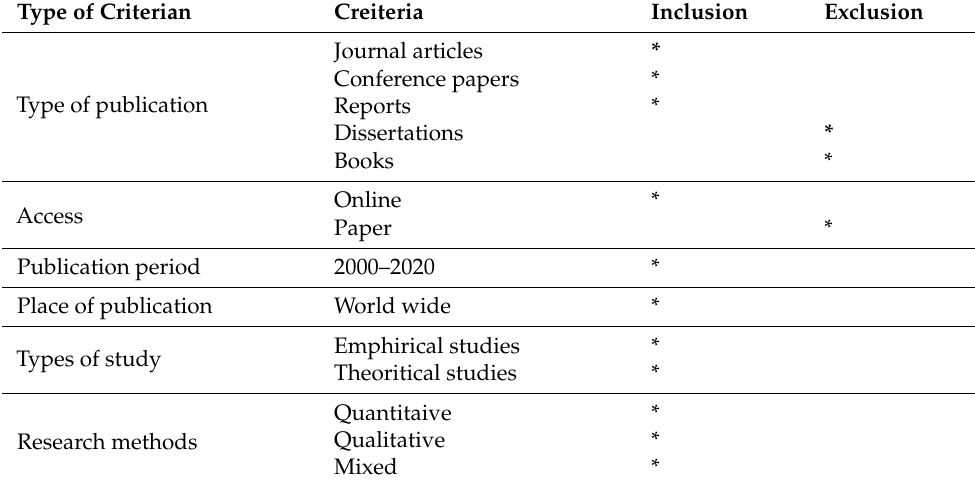
Table 3. Inclusion and exclusion